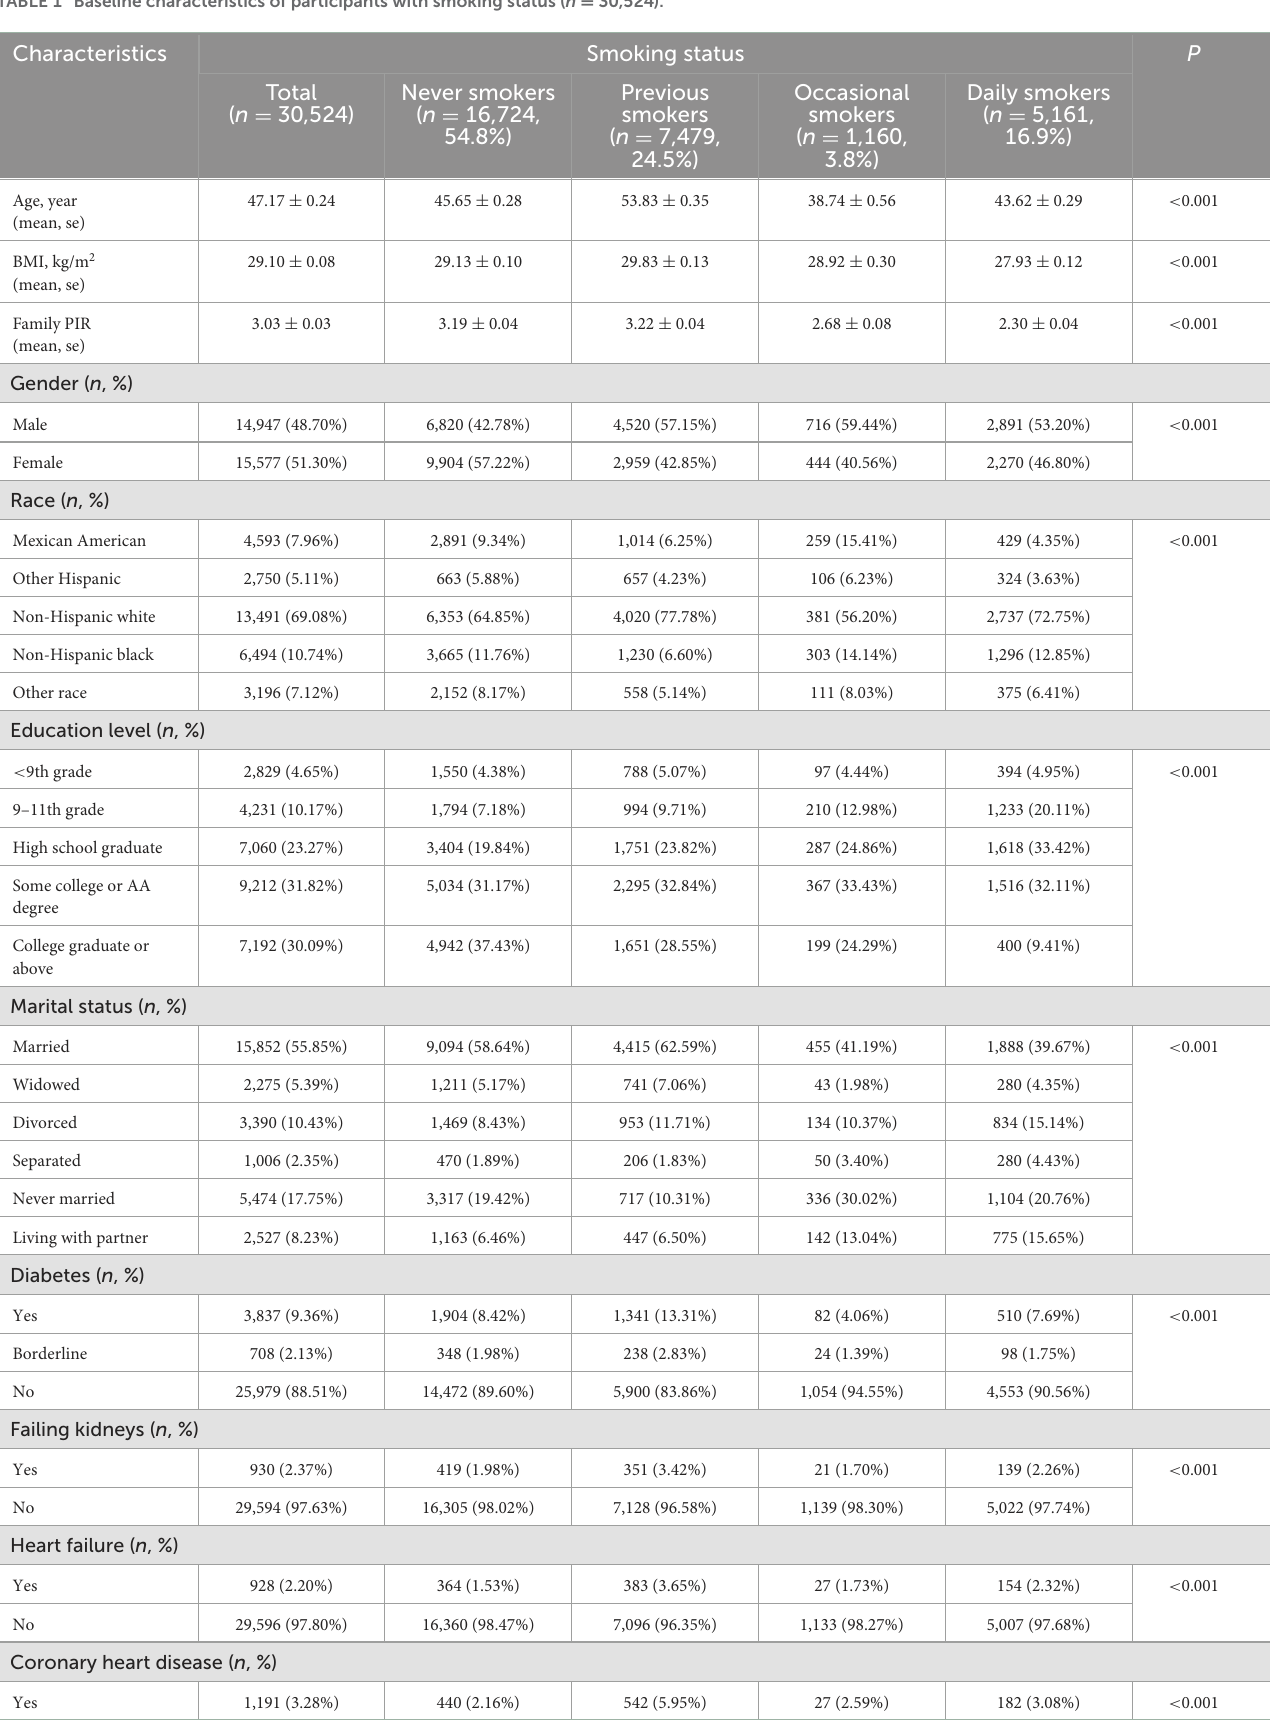
TABLE 1 Baseline characteristics of participants with smoking status ( n =